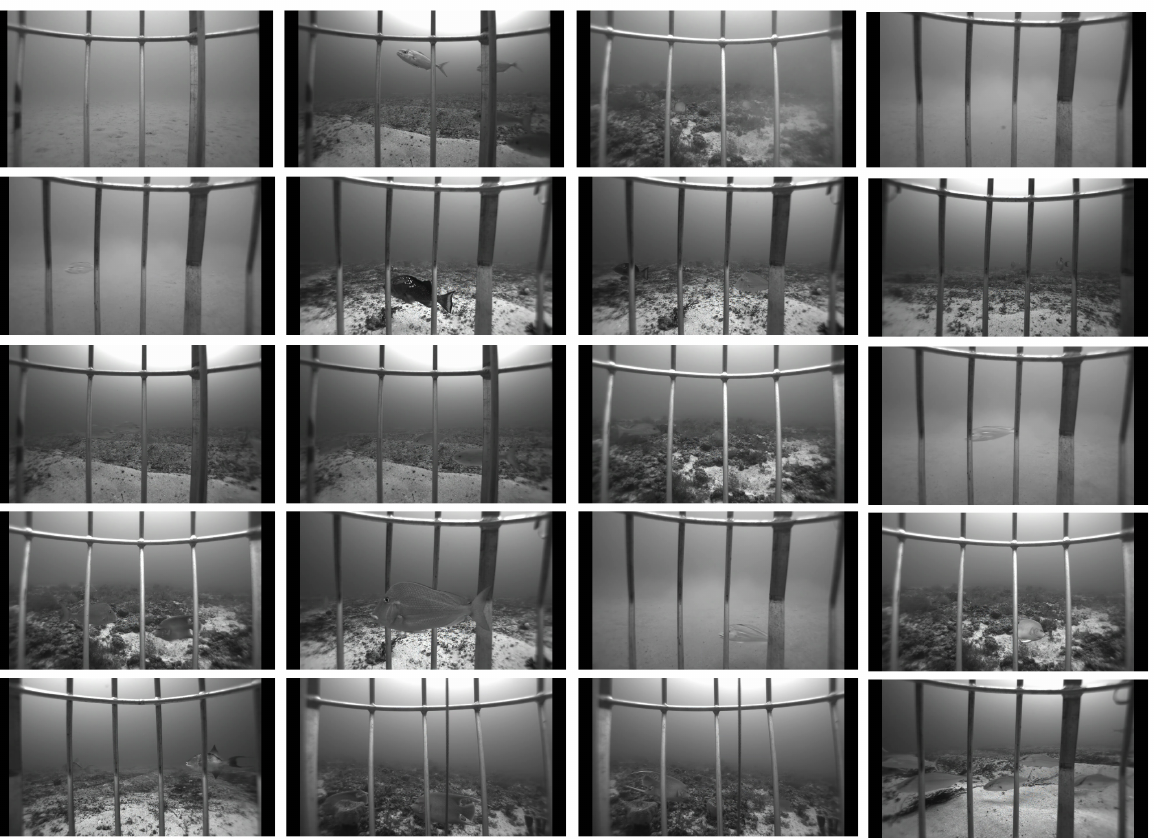
Figure 4. Sample images from the SEAMAPD21 dataset. The images are almost similar to the background, which makes the identification more challenging. Some of the fish images are challenging even for humans to detect. There might be occlusion due to vertical bars or other fish as